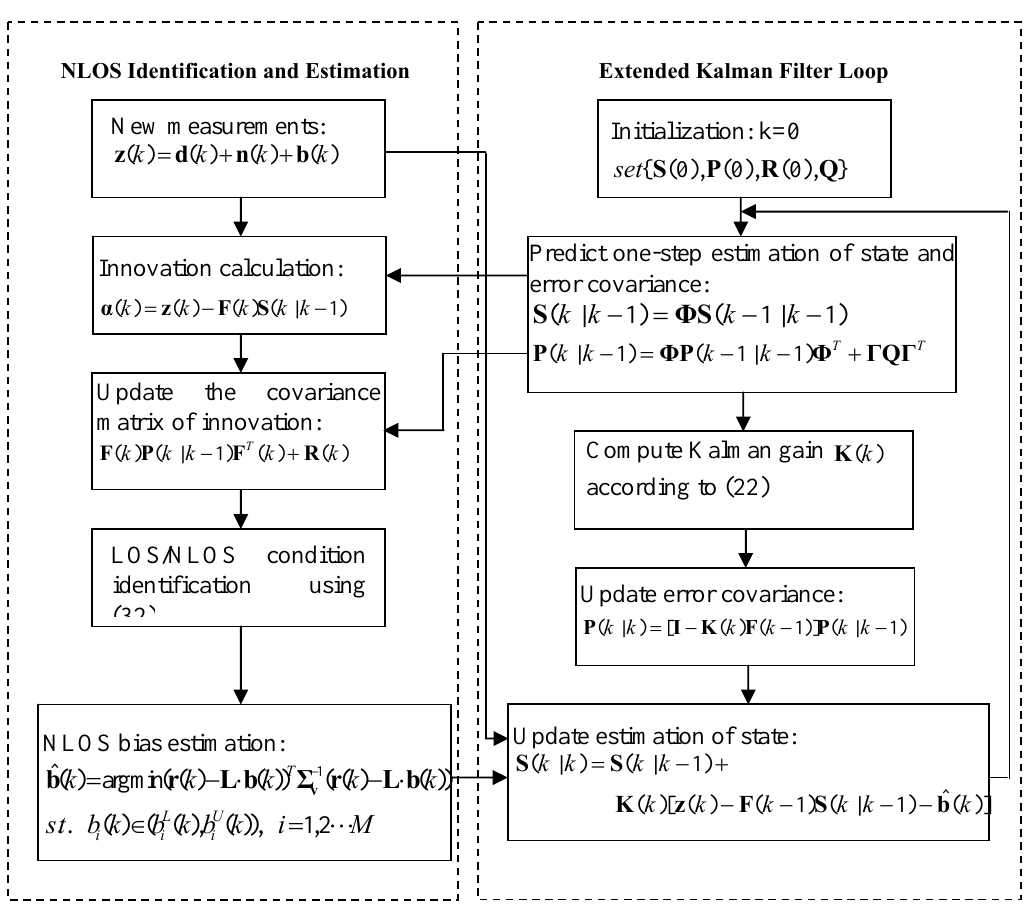
Figure 1. Flow chart of the proposed algorithm with NLOS